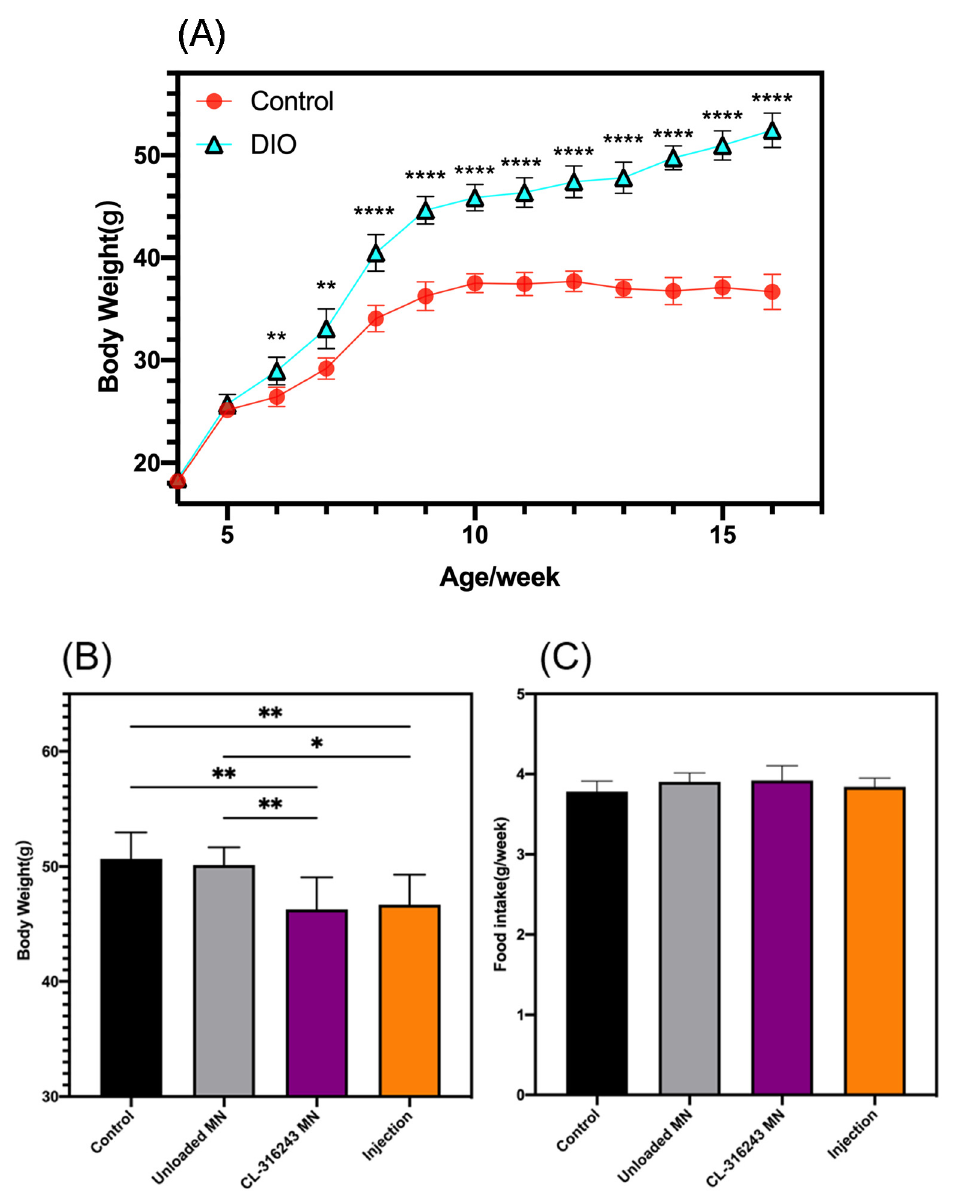
Figure 5. ( A ) Body weight in model group and control group; ( B ) Food intake of mice after dosing; ( C ) Body weight with different treatments. ( A ) Error bars indicate standard deviation (SD), two-tailed Student’s t -test, ** p < 0.01, **** p < 0.0001 compared to control group ( n = 10). ( B , C ) Error bars indicate SD, Ordinary one-way ANVOA test, * p < 0.05, ** p < 0.01 ( n = 15).